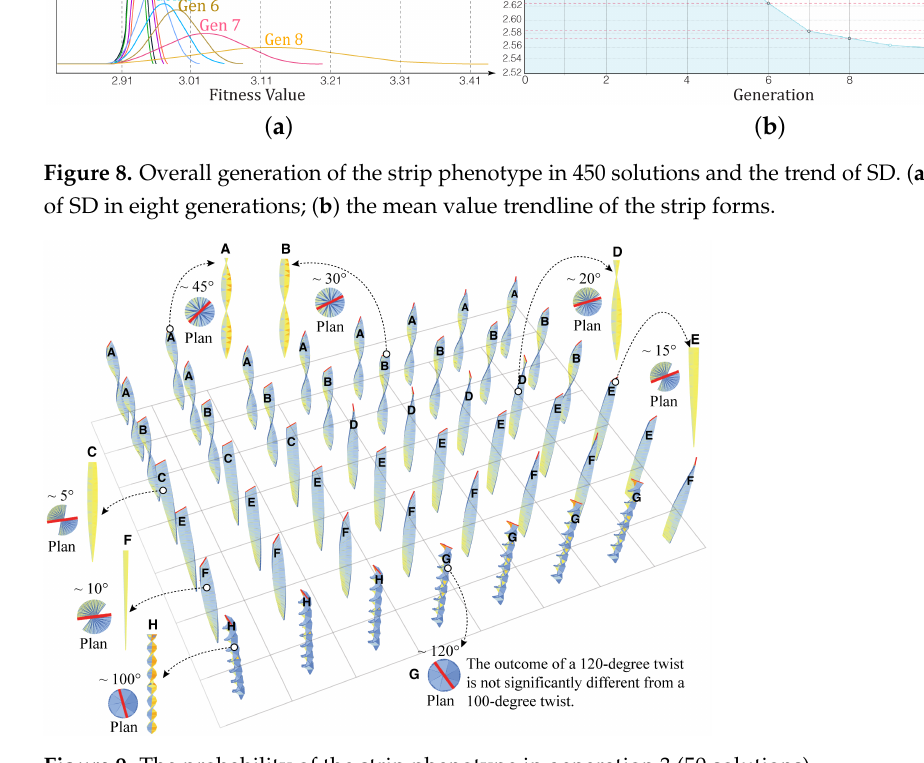
Figure 9. The probability of the strip phenotype in generation 3 (50 solutions).